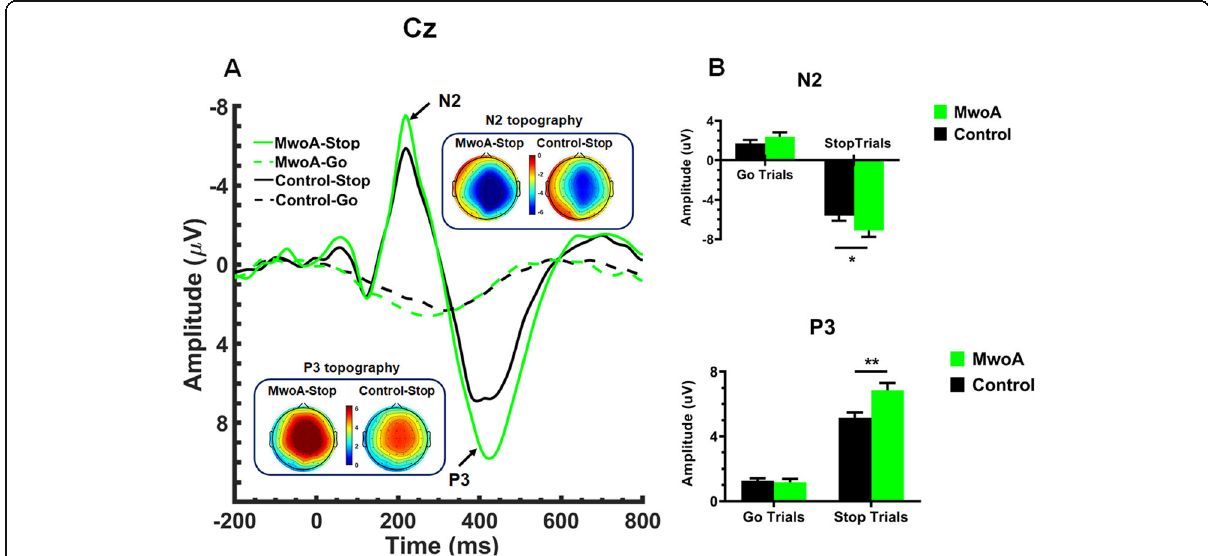
Fig. 2 Time-domain ERPs results. a Grand average ERP waveforms recorded at Cz evoked by Go signals (dashed lines) and successful Stop signals (solid lines), and the topography of the N2 (200 – 250 ms) and P3 (350 – 500 ms) in patients with MwoA and healthy controls. b Means and standard errors (SEs) of the amplitudes of the N2 and P3 in the two groups. *denotes p < 0.05 and **denotes p <